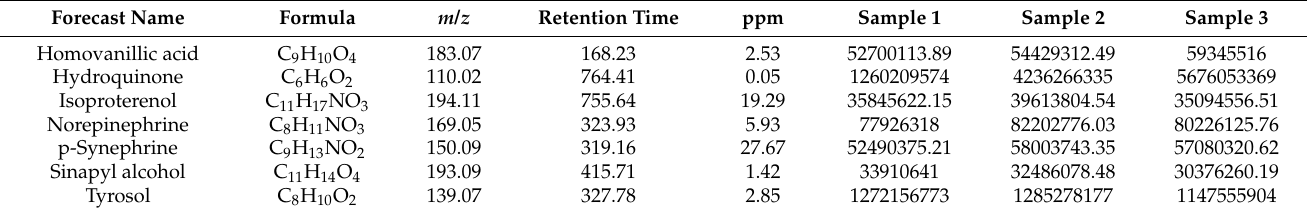
Table 2. LC–MS analysis of polyphenol extract of Forsythia suspensa